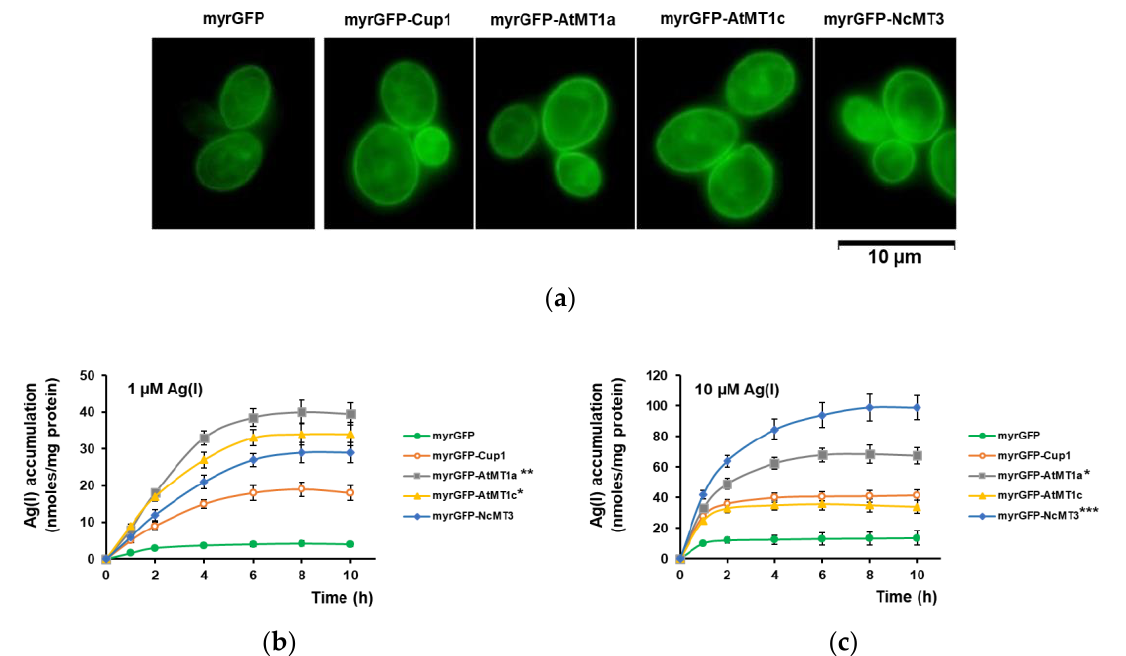
Figure 4. Ag(I) accumulation by selected strains. The cup2 ∆ cells transformed with URA3 -based plasmids harboring myrGFP (control), myrGFP-Cup1 (yeast MT), myrGFP-AtMT1a, myrGFP-AtMT1c and myrGFP-NcMT3 under the control of GAL1 promoter were pregrown in MM/Raf-Ura then shifted to galactose-containing medium for transgene induction. ( a ) Cellular localization of myrGFP-MTx. Transgenic cells were shifted to MM/Gal-Ura. Live cells were visualized by fluorescence microscopy using a GFP filter set. Images shown were taken 6 h after the galactose shift. ( b , c ) Accumulation of Ag(I) over time. Transformed cells pregrown in MM/Raf-Ura were shifted to MMLC/Gal-Ura and incubated 6 h for transgene induction (30 ◦ C, 200 rpm) before Ag(I) was added at 1 µ M ( b ), and 10 µ M ( c ), final concentrations. Cells were incubated with Ag(I) for various times and harvested for metal assay. One-way ANOVA ( b , c ) followed by Bonferroni’s test compared to myrGFP-Cup1. * p < 0.05; ** p < 0.01; *** p < 0.001.